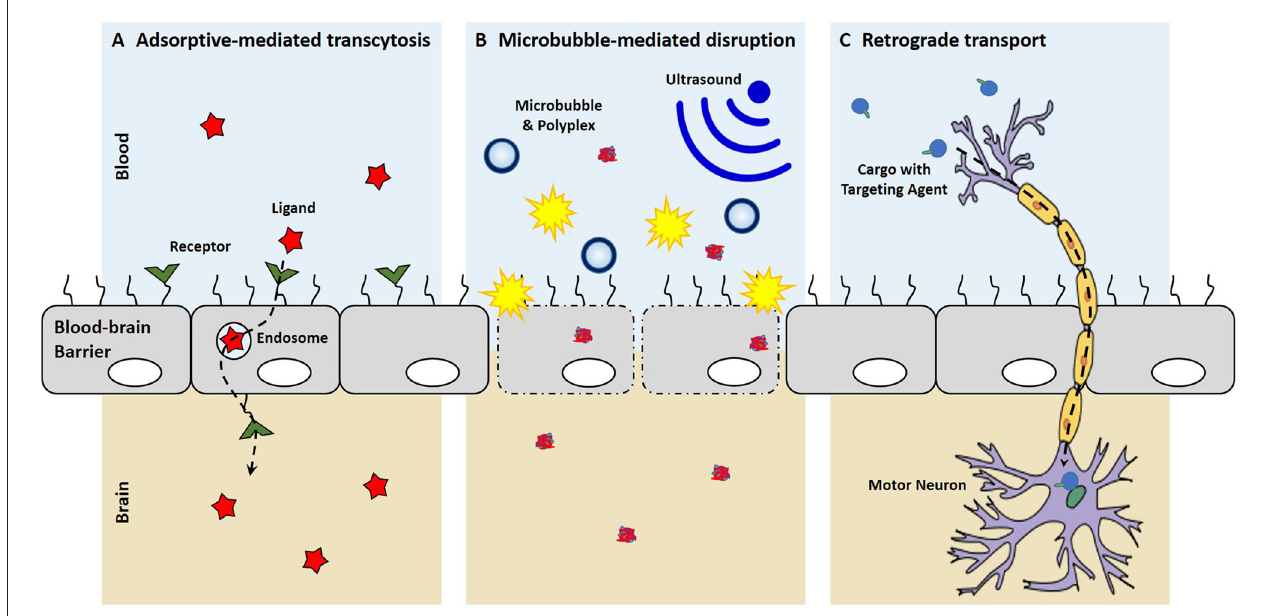
FIGURE 2 | Mechanisms of entering the central nervous system (CNS). (A) With receptor-mediated endocytosis, the binding of a ligand to its receptor on the brain endothelium facilitates cellular endocytosis, vesicular trafficking and eventually exocytosis on the contralateral side into the brain. (B) Microbubble-mediated disruption of the choroid plexus epithelium breaks tight junctions and creates micropores, allowing for the enhanced penetration of polyplexes into the brain. (C) New targeting ligands allow for uptake by peripheral neurons and the retrograde transport of cargo along axons to cell bodies in the